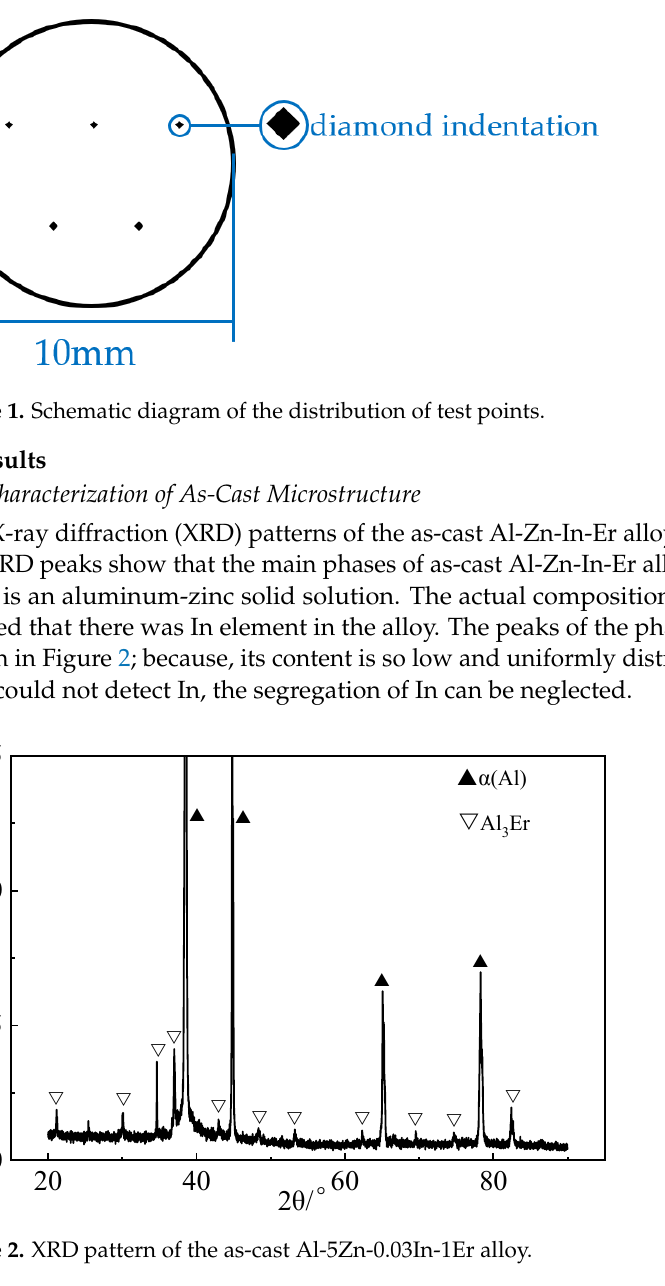
Figure 2. XRD pattern of the as-cast Al-5Zn-0.03In-1Er alloy. The OM and SEM images of the as-cast alloy are shown in Figure 3. As shown in Figure 3a, the as-cast microstructure is composed of an interdendritic α (Al) phase and a eutectic-like phase between the dendrites and the matrix α (Al) is equiaxed. Many coarse continuous nonequilibrium phases are observed in the as-cast alloy. As the white net-like